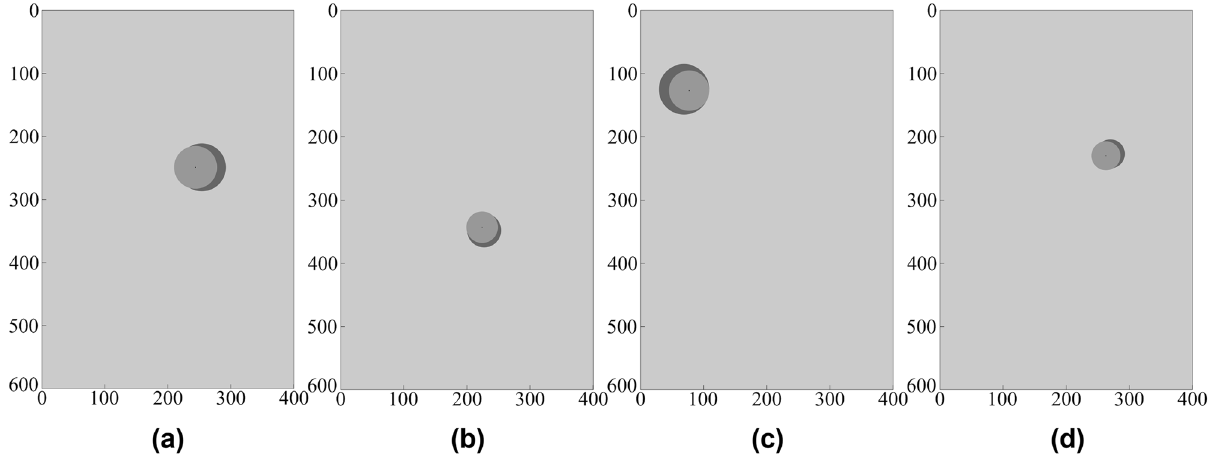
Figure 11. Prediction of geophysical parameters of the object, obtained using the proposed surrogate model (built based on the DS4 dataset). The target and surrogate-predicted object marked using the dark- and light- grey shade, respectively: ( a ) D = 249 mm, P = 254 mm, R = 38 mm, ( b ) D = 348 mm, P = 227 mm, R = 27 mm, ( c ) D = 125 mm, P = 69 mm, R = 40 mm, ( d ) D = 227 mm, P = 270 mm, R = 23